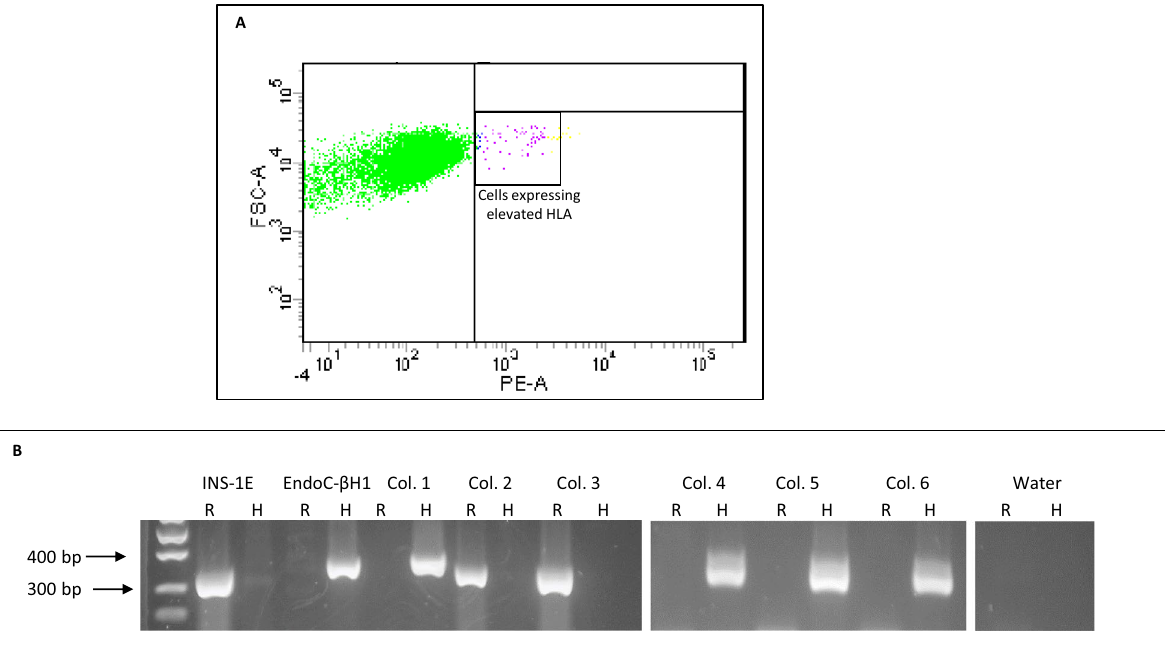
Figure 4. Sorting and expansion of 1.1B4 cell clones expressing human HLA class I. ( A ) 1.1B4 cells (passage 28) were treated with 1000 U/ml human interferon-alpha for 24 h then sorted by flow cytometry after staining with a human-specific anti-HLA class I antibody. Cells which had upregulated HLA class I (purple and yellow symbols) were selected and seeded into single cells in 96 well plates and expanded. ( B ) After expansion, 6 colonies were selected and genomic DNA isolated for analysis by PCR using species-specific (R – rat; H- human) vomeronasal receptor primers. INS-1E (rat) and EndoC-βH1 (human) cells were analysed in parallel as controls. Images of the whole gel are available in supplementary